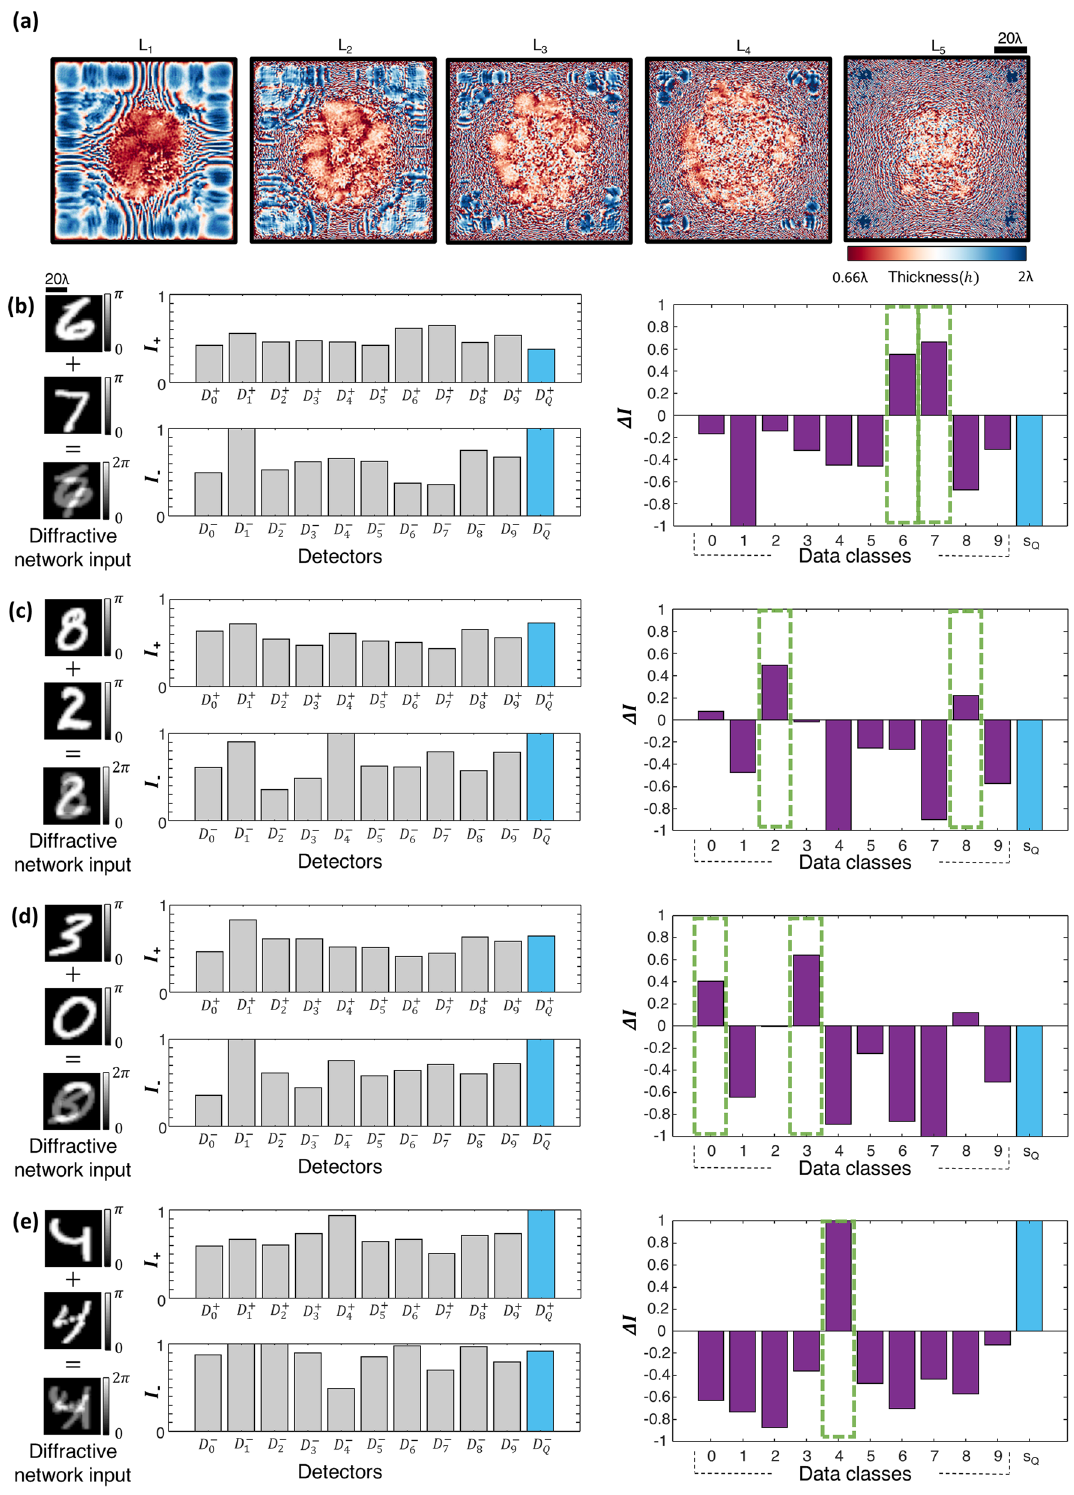
Figure 5. All-optical classification of spatially-overlapping phase objects using the diffractive optical network D 2 NN-D2d, based on the detector layout scheme D-2d shown in Fig. 1e. ( a ) The thickness profiles of the diffractive layers constituting the diffractive optical network D 2 NN-D2d at the end of its training. This network achieves 85.22% blind inference accuracy on the test image set T 2 . ( b – e ) Left: Individual phase objects (examples) and the resulting input phase distribution created by their spatial overlap at the input field-of-view. Middle: The normalized optical signals, I + and I − , synthesized by D 2 NN-D2d at its output detectors. Right: The < I differential optical signal, (cid:31) I = I + − I − (purple). For I D + D − Q , the largest two differential optical signals correctly reveal the Q ≥ I classes of the overlapping input phase objects (indicated with the green rectangular frames in ( b – d ). For I D + D − Q , the largest Q differential optical signal correctly reveals the class of the overlapping input phase objects (indicated with the green rectangular frame in ( e